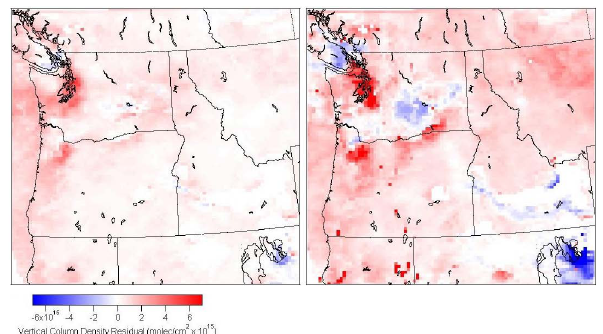
Fig. 16. AIRPACT – OMI tropospheric NO 2 column residuals with the daily averaging kernels from OMI applied to AIRPACT is shown for a winter (January 2008) monthly average. This scat- ter plot of AIRPACT × NASA AK – NASA OMI vs AIRPACT × DAK – KNMI OMI is separated by color into dominant land class type (obtained from the US National Land Class Database and GEOBASE Canada, 2001 Land Class/Land Use using LandSat-7 derived radiances survey). One would expect the distribution to fall along the 1 to 1 line if the two products suggested the same model biases.